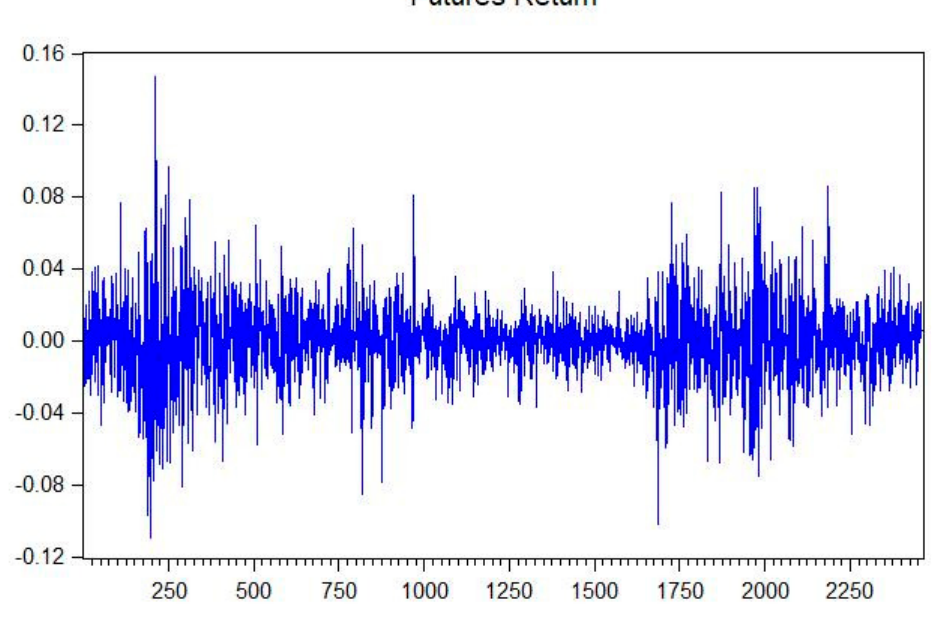
Figure 2. Price return trend chart of Brent oil futures.